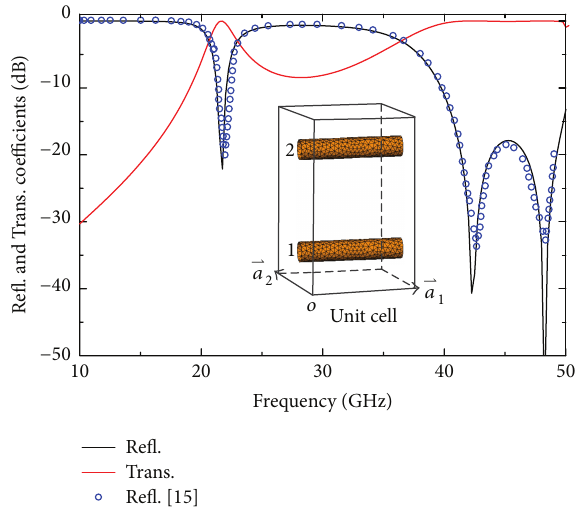
Table 1: Compression rate 𝜂 (%) of matrix